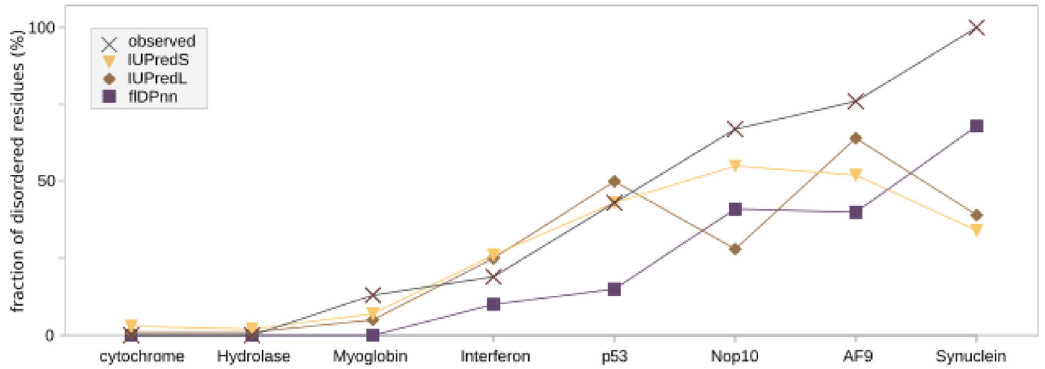
Figure2.Predictedpercentageofresiduesinadisorderedregionforexperimentallysolvedproteinstructures as controls. The disorder for four highly structured and four highly disordered proteins with